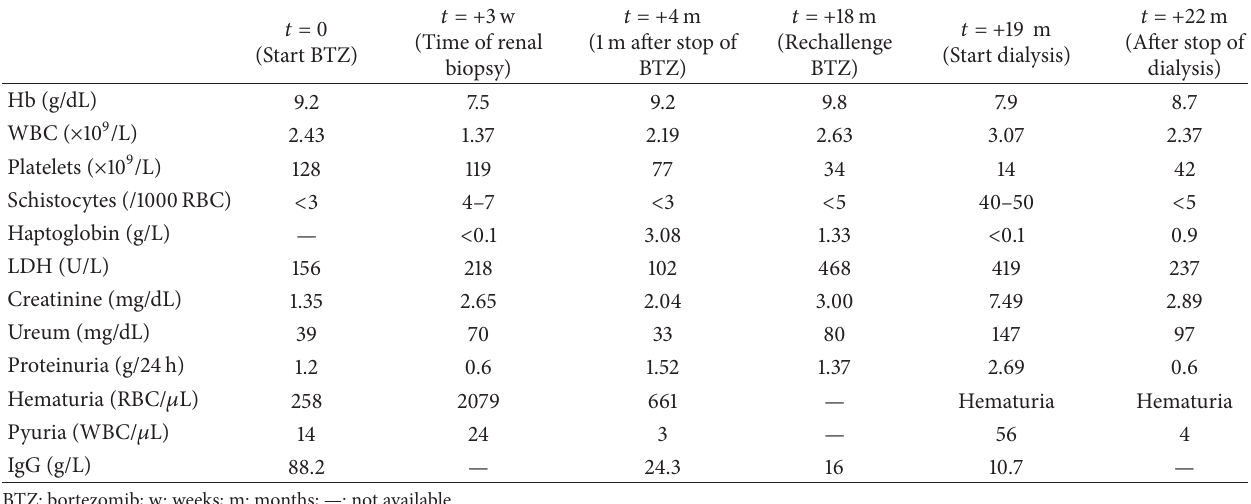
Table 1: Laboratory values.